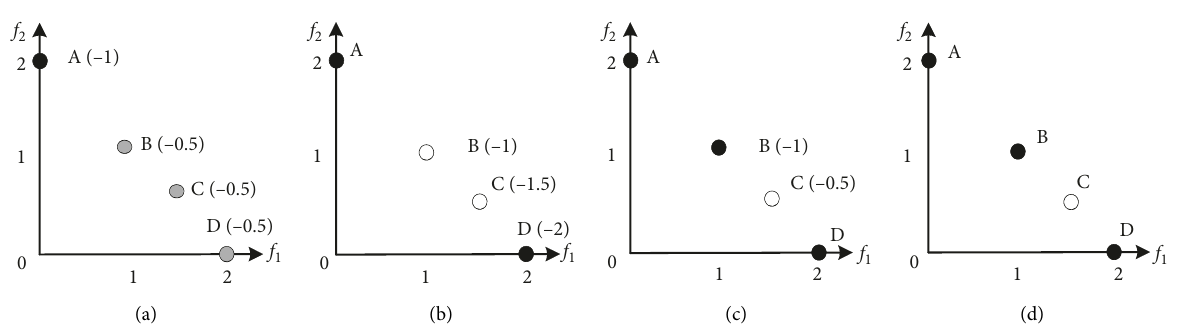
Figure 5: Diagram of the process of solving the equivalence selection problem by one-by-one comparison